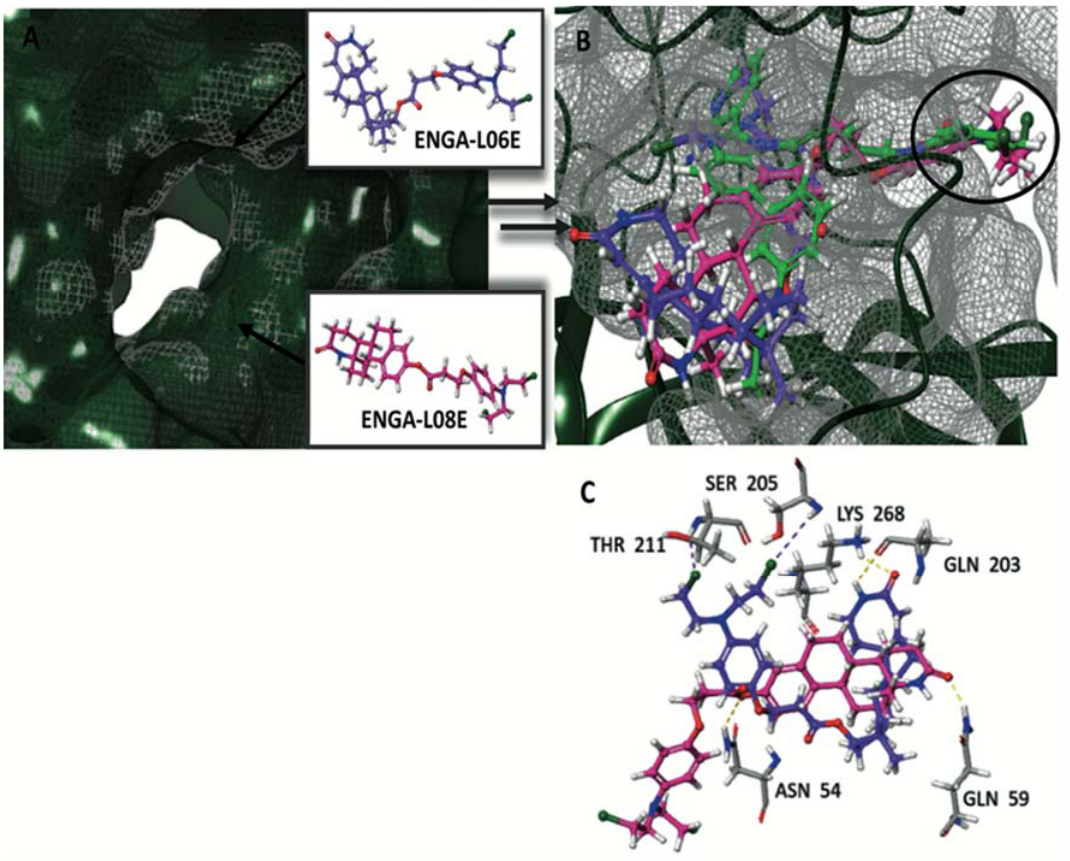
Figure 9. ( A ) The active site cavity of AKT1 and ( B ) Superimposition of the calculated molecules ENGA-L06E and ENGA-L08E, given in purple and pink colored carbons, respectively, with the co-crystallized ligand of AKT1, 0R4 (with green color) and ( C ) The critical network bonding residues are labeled in yellow and purple dashed lines.